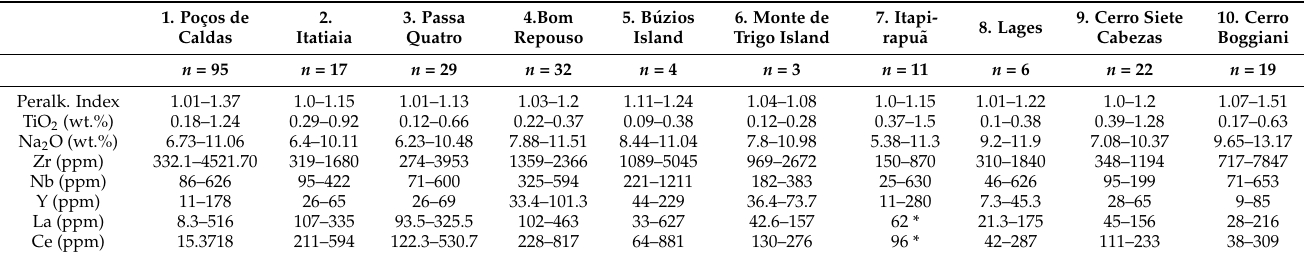
Table 2. Whole rock geochemical characteristics of peralkaline varieties from the studied massifs. Souces: 1. [14], 2.